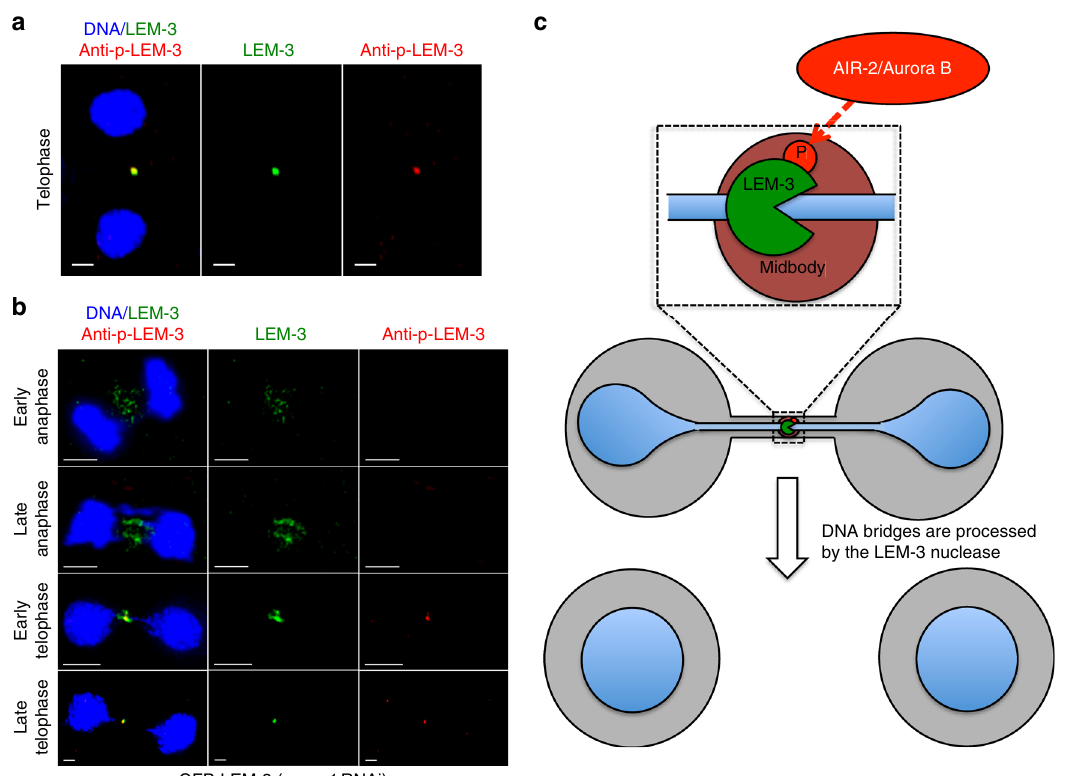
Fig. 6 LEM-3 is phosphorylated at the midbody. a Co-localization of GFP-LEM-3 and phospho-LEM-3 at the midbody. Scale bars: 5 μ m. b Localization of LEM-3 and phosphorylated LEM-3 in the presence of chromatin bridges from anaphase to telophase. c Proposed model for chromatin-bridge processing by the midbody associated LEM-3